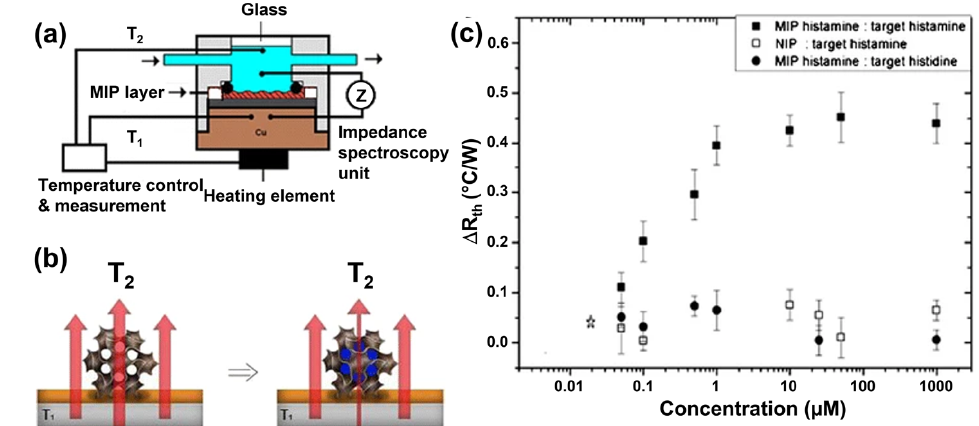
Figure 13. ( a ) Concept of the heat transfer method HTM. A chip, functionalized with a MIP layer, is heated from its backside to a given temperature T 1 , e.g., 37 °C. The temperature in the sample compartment, T 2 , is measured and allows calculating the heat transfer resistance R th of the interface. ( b ) The porous structure of the MIP particles (symbolized by an open hexagram) enables facile heat transfer to the supernatant liquid, which diminishes when bound target molecules block the pores, resulting in a drop of T 2 and an increase of R th . ( c ) Concentration-dependent increase of R th for increasing histamine concentrations, and the LoD is 100 nM. There is no response to histidine and no histamine response for nonimprinted polymer particles. Figure reprinted with permission by Springer from ref. [194], published in Analytical and Bioanalytical Chemistry , Copyright